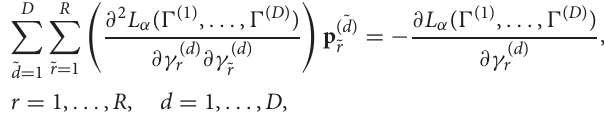
FIGURE 6 | Replacing the term separable expansion is sufficient to get a an approximation that is capable of capturing the global features of Equation (20). We used 8,000 random function samples for our training set. The fits were obtained with a B-spline basis comprising of a uniformly distributed knot set and M between the true function (Equation 19) and the obtained approximation using (Equation